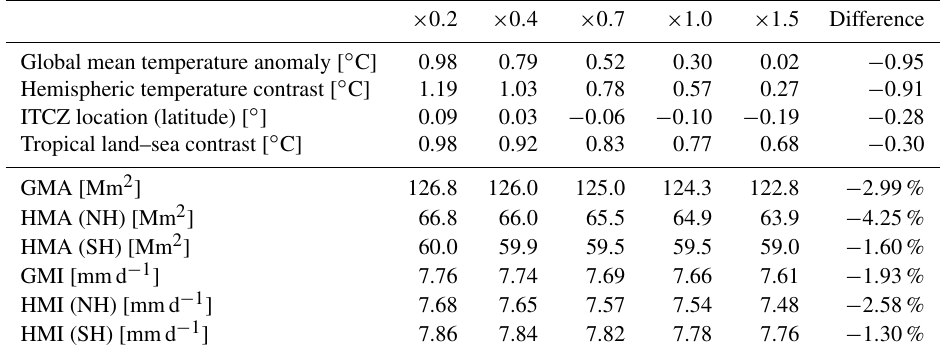
Table 1. Mean monsoon-related properties, as defined in Sects. 3 and 4, averaged over the period 1950–2014 (during which global aerosol emissions increased), and all five ensemble members. The difference column is the change from × 0 . 2 (lowest scaling) to × 1 . 5 (highest scaling), expressed as a percentage where indicated. × 0 .